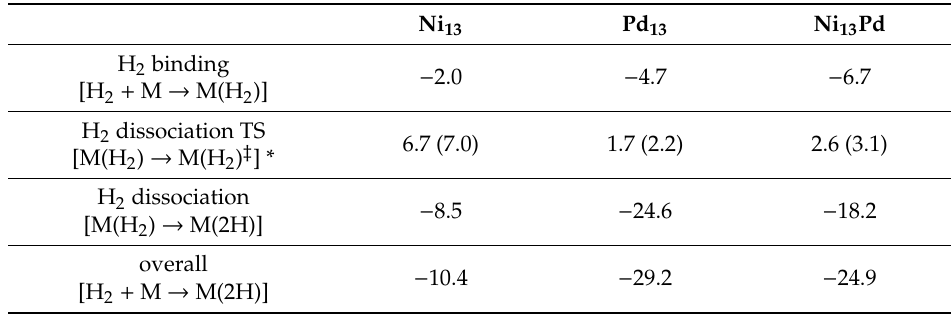
Table 2. Calculated energetic e ff ects of hydrogen binding to the model metal nanoparticles (Ni 13 , Pd 13 , and Ni 13 Pd) and H 2 dissociation at the surface of the nanoparticles. For the latter, the transition state (TS) energy for the deuterium-substituted system is provided in parenthesis. All reported energies are in kcal / mol and are corrected for zero-point energy change